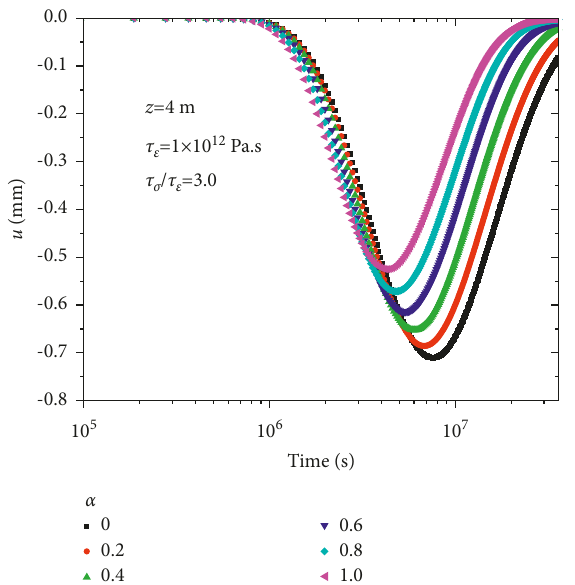
Figure 7: Influence of the order of the fractional derivative on displacement when τ